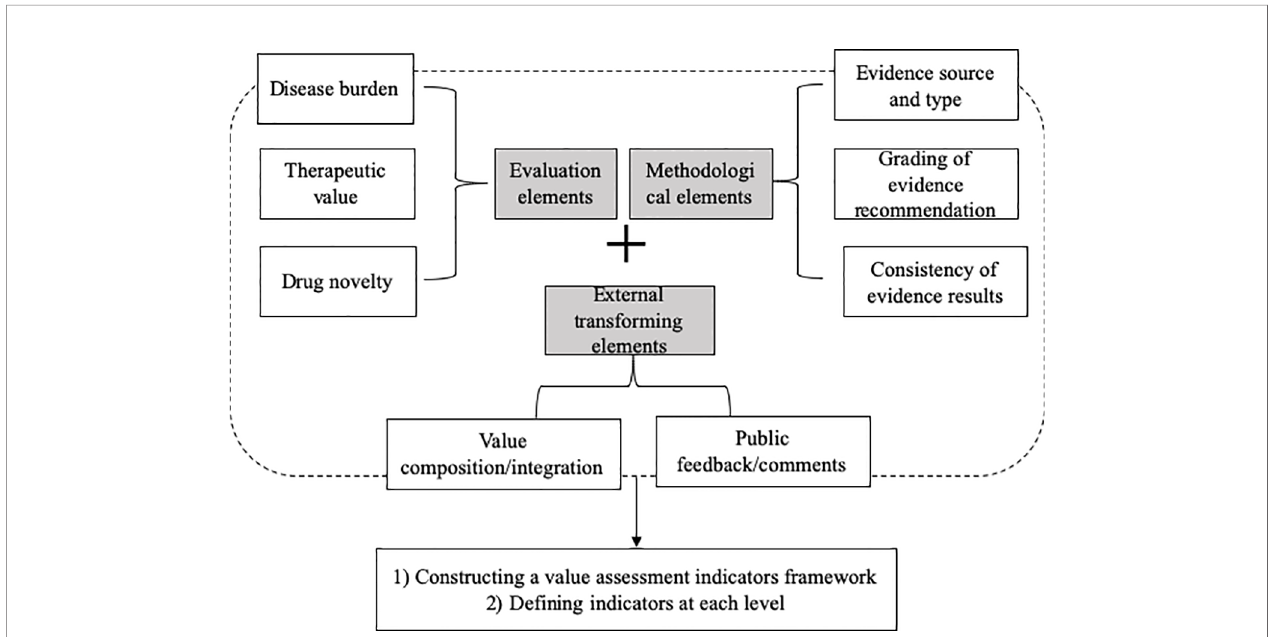
FIGURE 1 | Study design of the Delphi